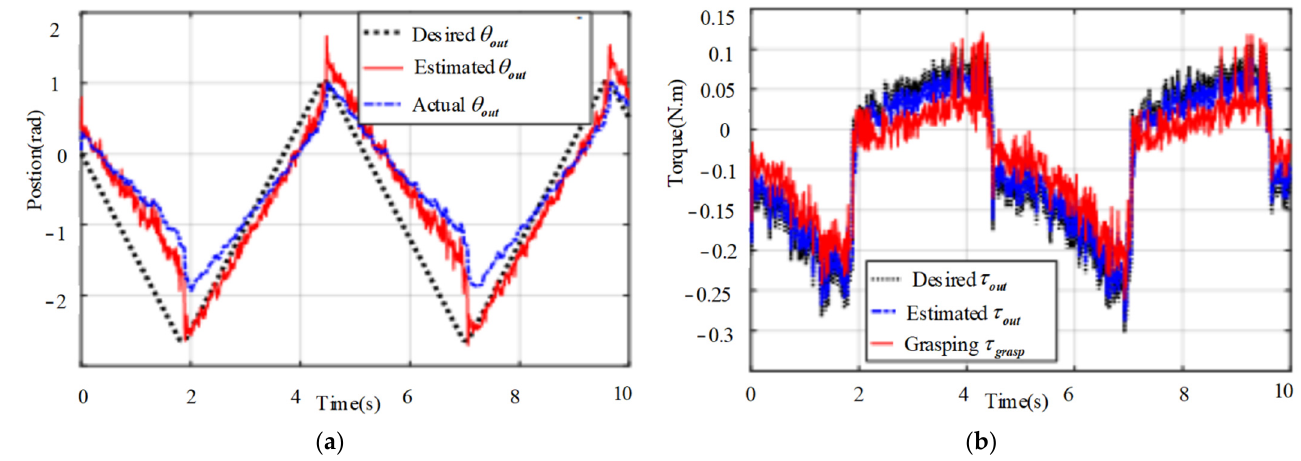
Figure 14. Comparison curves of the output displacement and grasping torque of distal graspers of the surgical instrument with transmission backlash compensation: ( a ) Comparison curve between the measured values and the desired values of the output displacement of the distal graspers; ( b ) Comparison curve between the estimated values and the desired values of the grasping torque of the distal graspers.